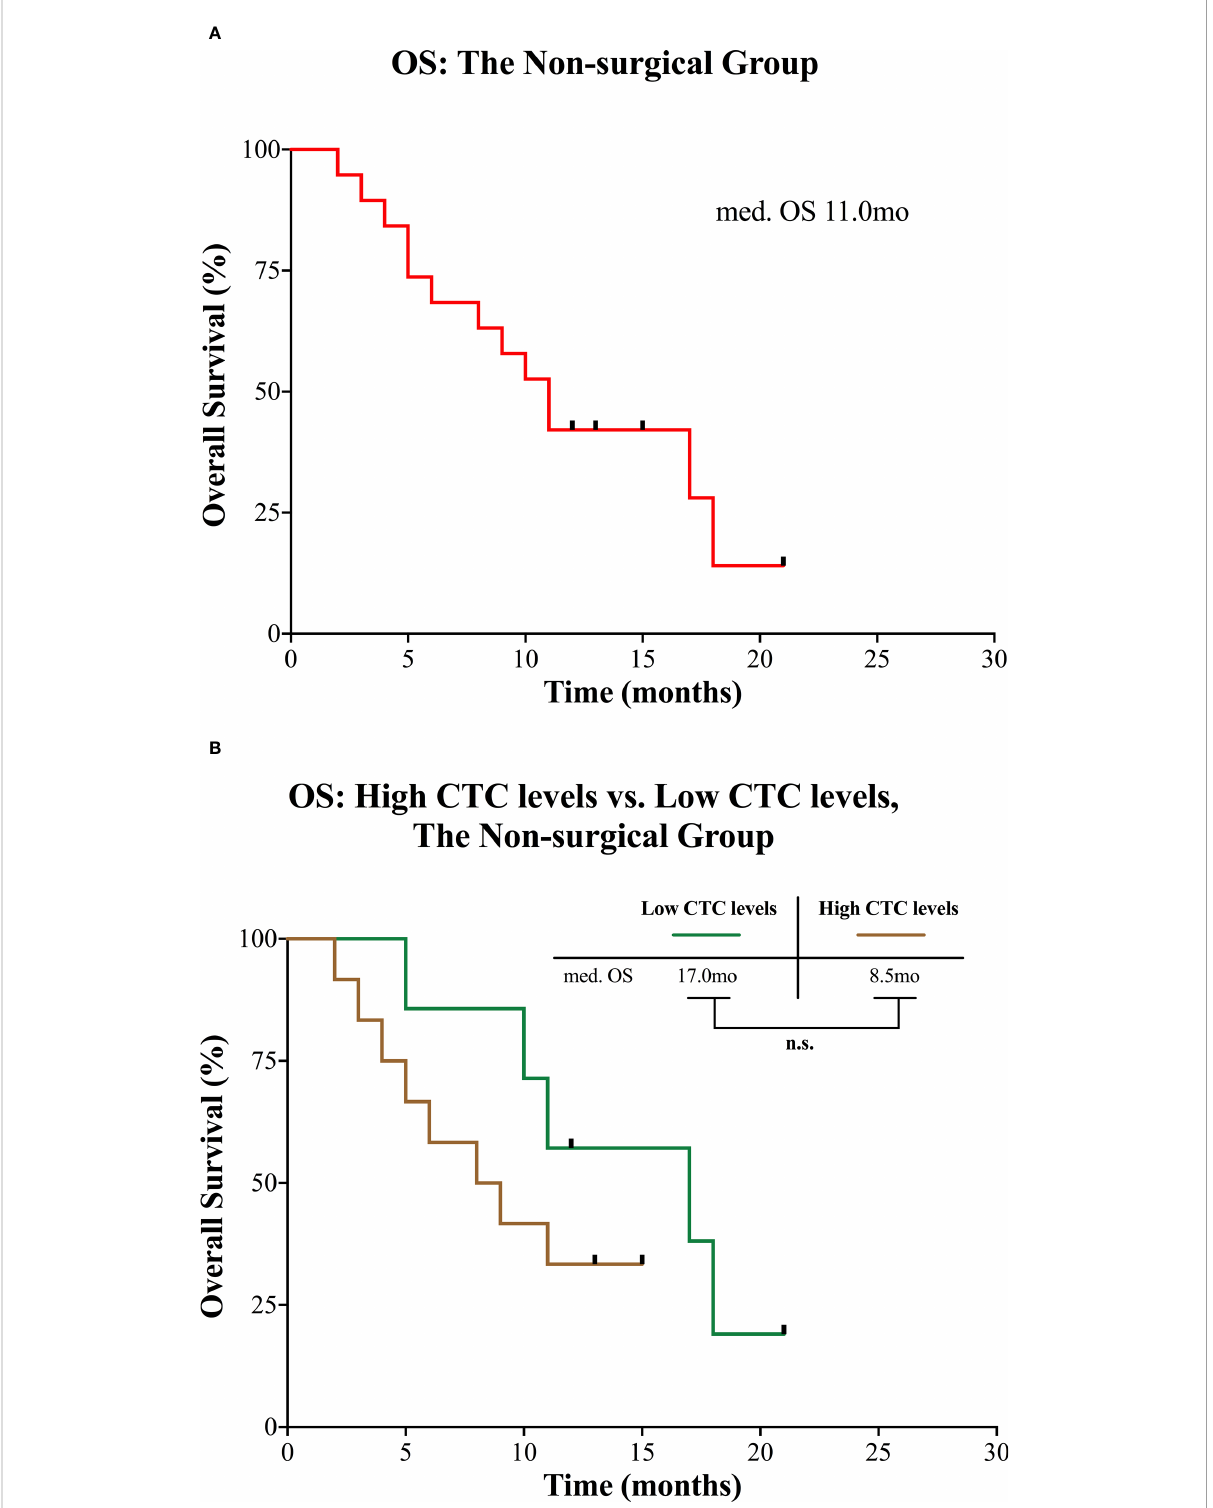
FIGURE 4 Kaplan-Meier curves for patients in the non-surgical group. (A) OS for the entire group. (B) OS of the non-surgical group divided into high and low CTC levels. CTC, circulating tumor cell; mo, months; med., median; n.s., not signi fi cant; OS, overall